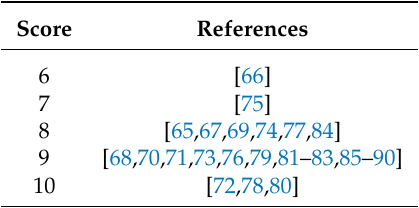
Table 12. Quality